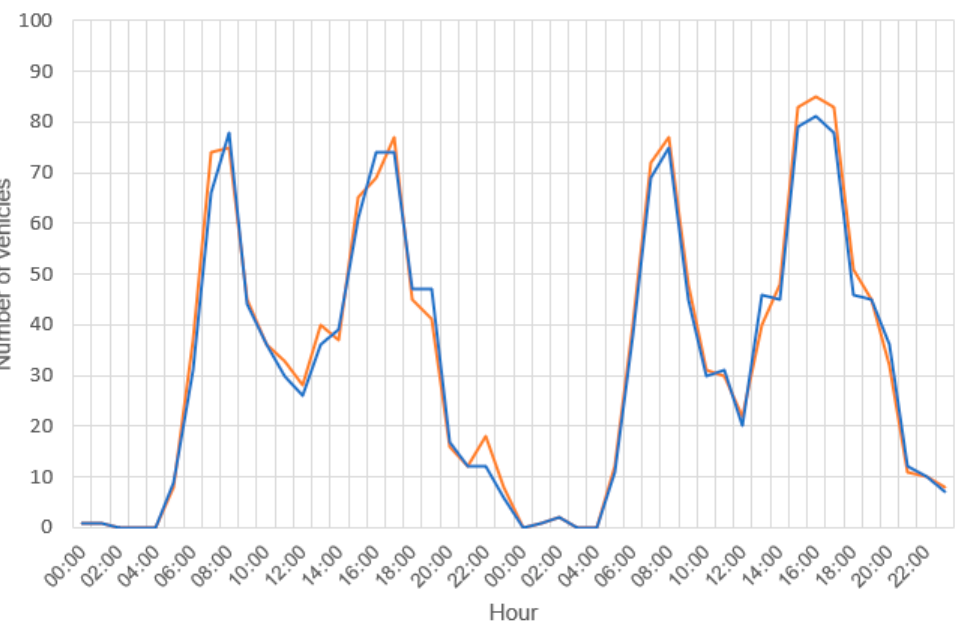
Figure 4. Comparison of the number of vehicles recorded by the microwave radar with the actual number of bicycles (own study).